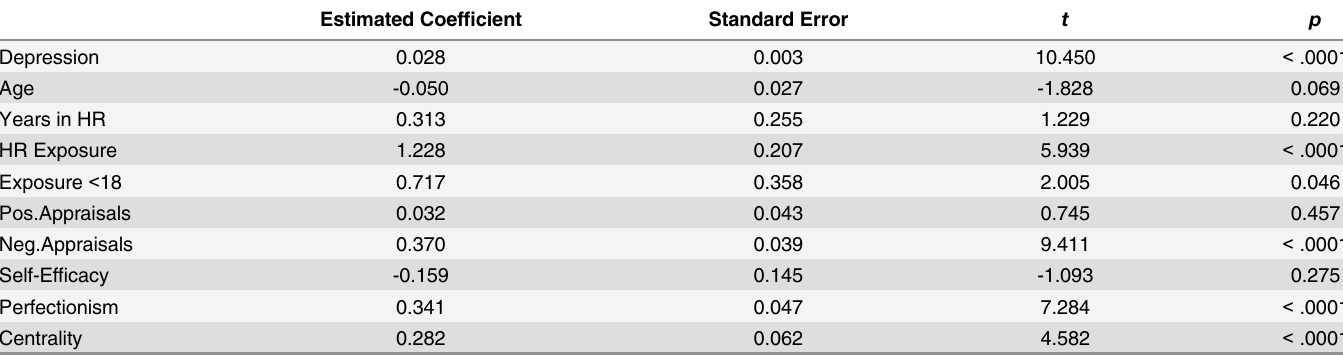
Table 4. Simple linear regression models predicting